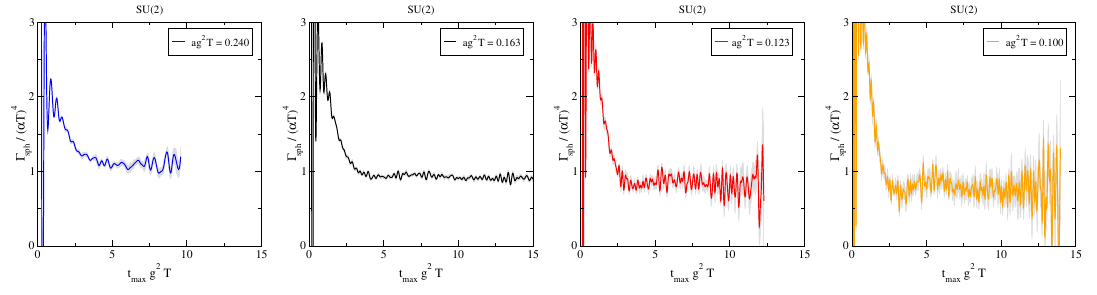
Figure 2 . Demonstration of the dependence of Γ to the volume dependence in figure 1, the dependence on t compared with the colour-magnetic scale ∼ 1 / ( g 2 T ) , apart from fast oscillations that average to zero. our local definition it does not go to zero). As the volume is increased, the rate